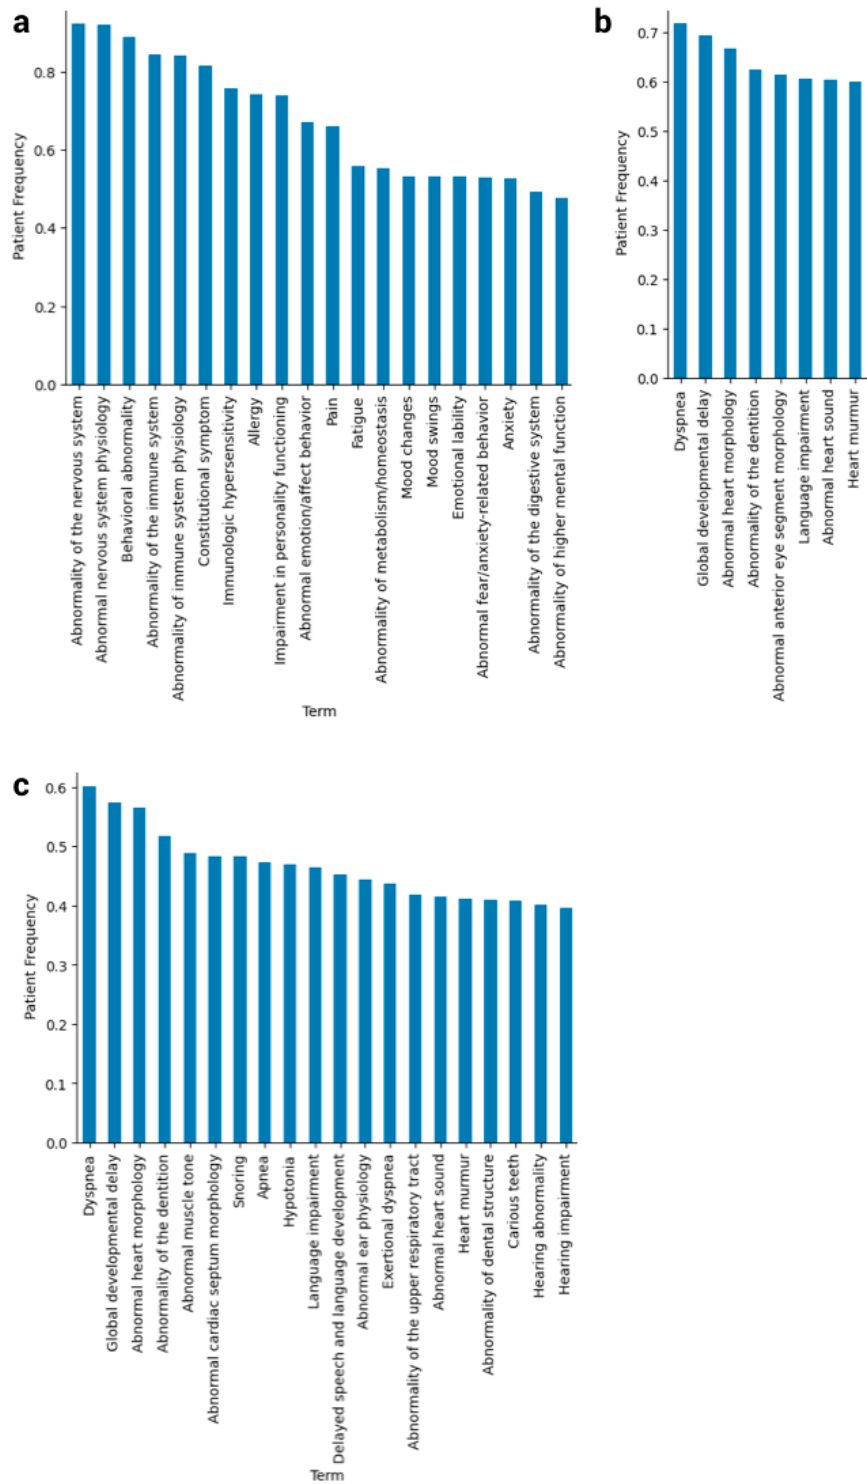
Figure 1. Phenotypic spectrum of HPO terms for Down syndrome and baseline patient cohorts. ( a ) These are the top 20 HPO terms from baseline patients ranked by patient frequency, or the proportion of the cohort possessing at least one instance of the term in its notes. ( b ) The top 20 HPO terms in DS patients ranked by patient frequency, after propagation up to “Phenotypic abnormality,” and before filtering on note length and quality. ( c ) The top 20 HPO terms in DS patients ranked by patient frequency, after both propagation and filtering.